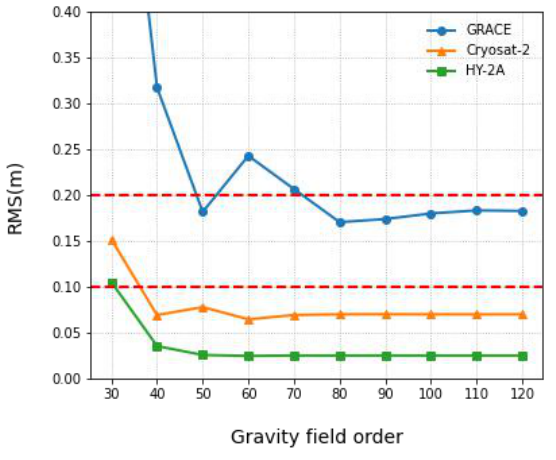
Figure 5. RMS(m) in radial direction for different orders in 30 minutes prediction.